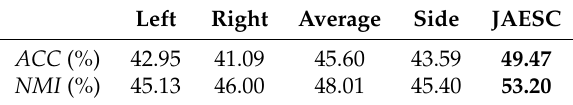
Table 3. Performances of the different channels of stereo audio with the proposed methods. “Left”, “Right”, “Average”, and “Side” refer to four channels of binaural representation. “JAESC” refers to joint clustering with four